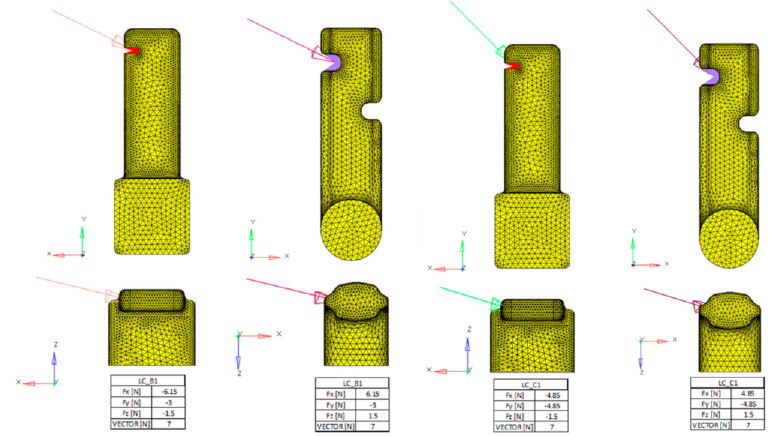
Figure 13. LC_B1 load case on the left and LC_C1 = spatial load on the right. LC_C1 = spatial load (Figure